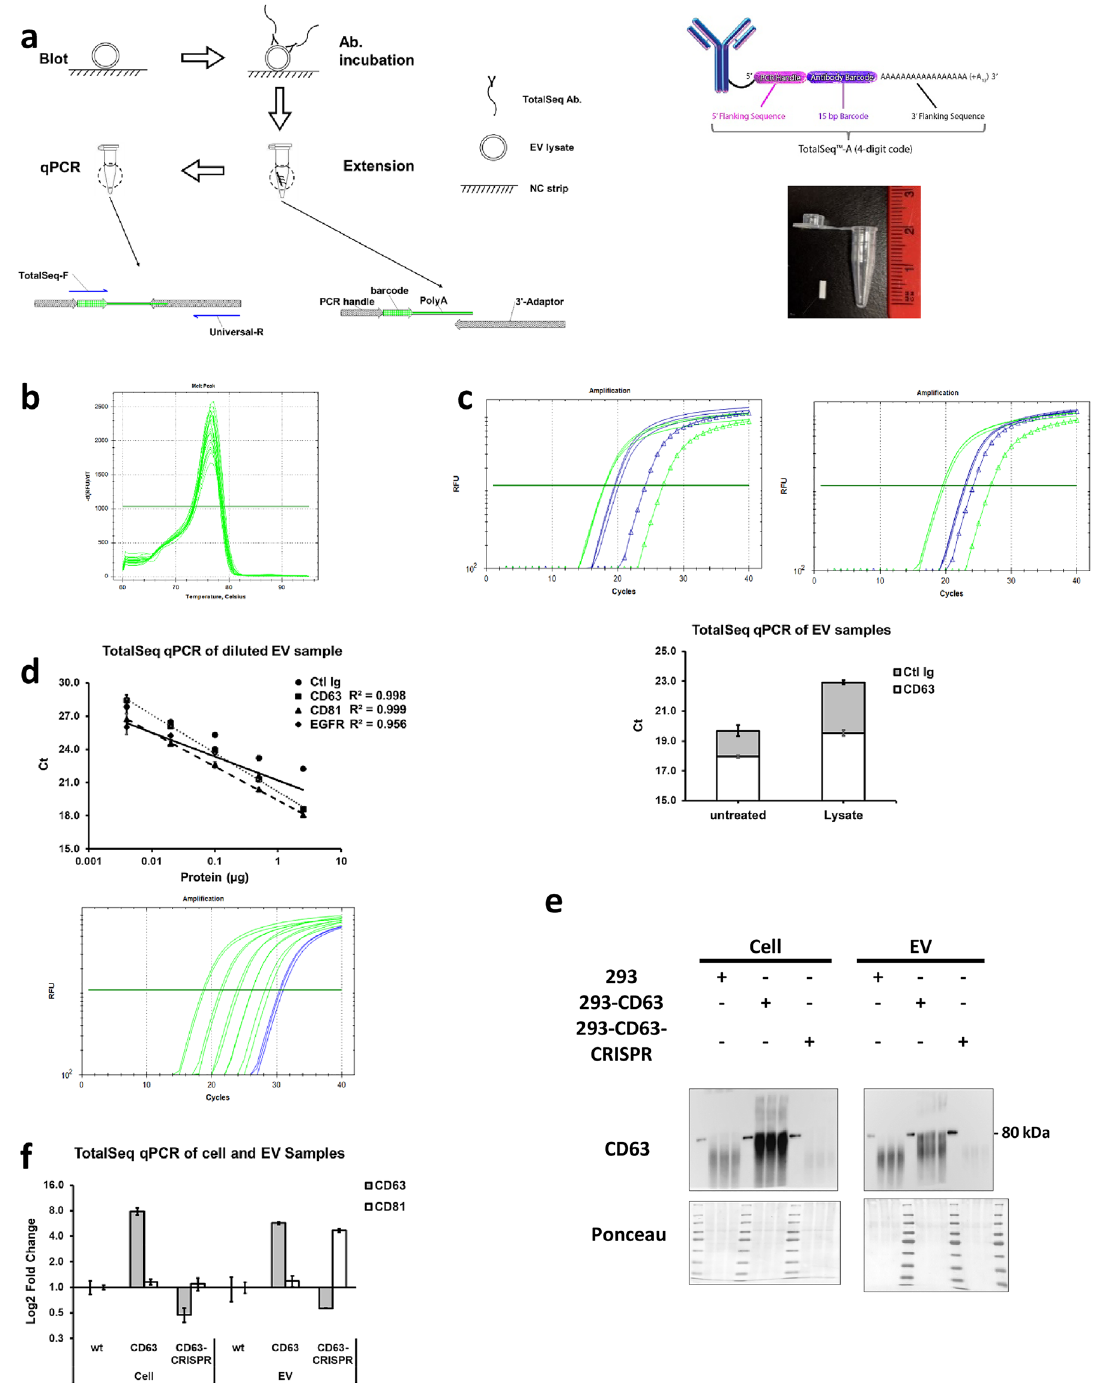
Figure 1. Protein sample were profiled with TotalSeq antibody. ( a ) Basic work flow for detection of immobilized protein sample by TotalSeq-A antibody. Structure of conjugated oligo in TotalSeq-A antibody (up right), reprint from BioLegend website with permission. Size and comparison of pre-cut strip and PCR tube (bottom right). ( b ) Melting curve of different TotalSeq antibodies on EV protein samples in triplicate. ( c ) Intact (upper left) or lysised (upper right) #1 EV samples were tested with TotalSeq CD63 (green) and control mIgG (blue) antibody in Triplicate. Equal amount of BSA (triangle) was used as negative control. Ct values of CD63 (white) and control mouse IgG (gray) are overlaid in column chart to show the difference. ( d ) Serial dilution of #1 EV sample was incubated with TotalSeq antibody CD63 (square), CD81 (triangle), EGFR (diamond) and control IgG (circle). Amplification curve (bottom) of CD63 on EV dilution (green) and BSA (blue). All experiments were performed in duplicate. ( e ) CD63 immunoblot result of EV and whole cell lysate. Full-length blots are presented in Supplementary Figure S7. ( f ) TotalSeq qPCR result on the same samples as in ( e ). Data were normalized to wild type HEK293